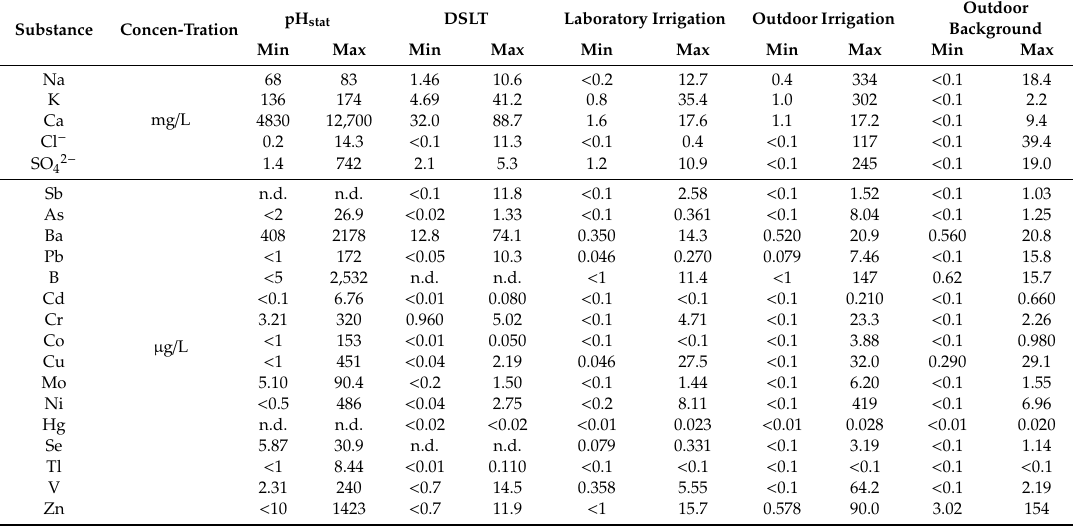
Table 7. Concentration range in the leaching